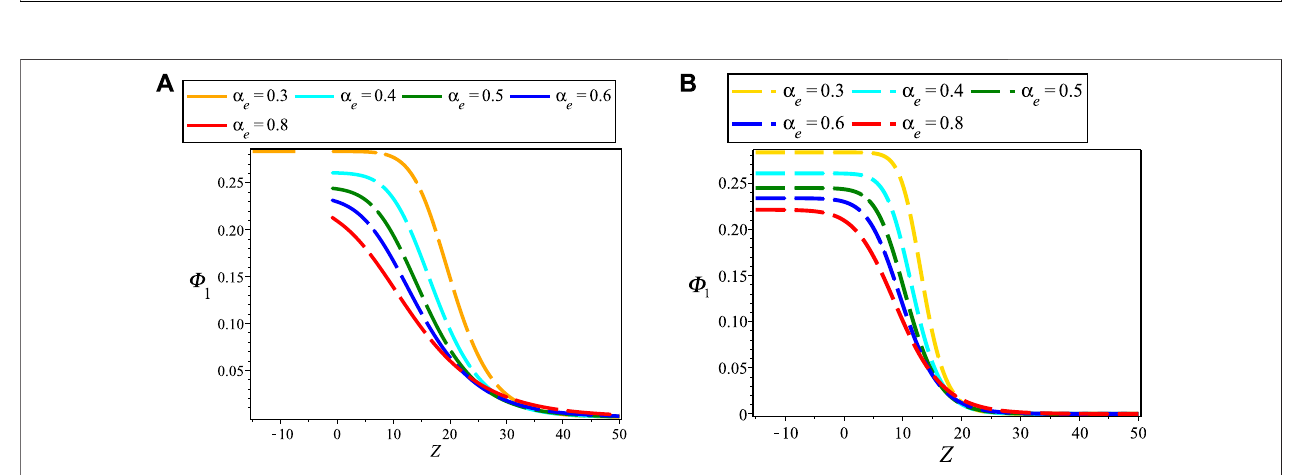
FIGURE5| ElectrostaticNIASWEsfordifferentof (A) α e with d (cid:2) 1, r (cid:2) e , β (cid:2) 0.9, N p 0 / N e 0 (cid:2) 0.5, ρ 0 (cid:2) 0.96, T ep (cid:2) 1, V i 0 / c (cid:2) 0.1and T (cid:2) 100;and (B) α e withthesame typical values of (A) except β (cid:2) 1.